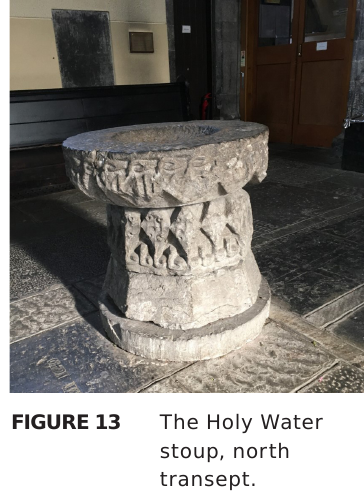
The Holy Water stoup, north